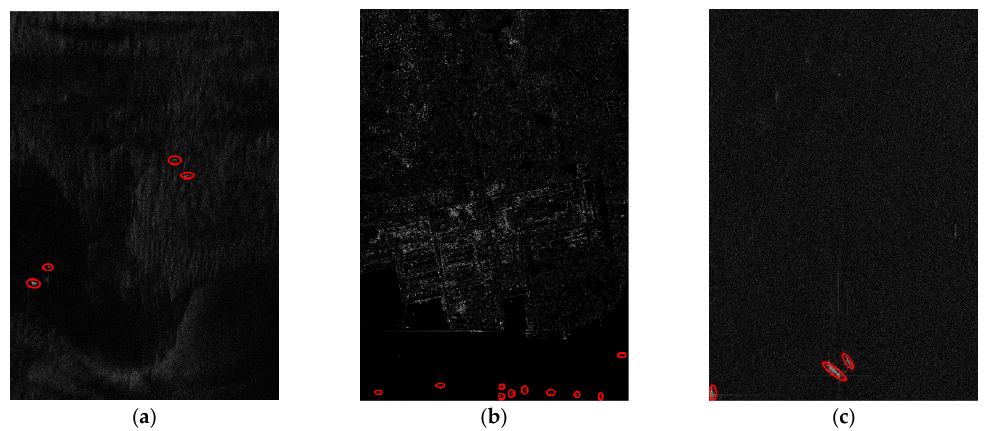
Figure 8. The sub-images to be detected with ground truth marked. ( a ) The sub-images #1 from image #1; ( b ) The sub-images #2 from image #2; ( c ) The sub-images #3 from image #3.